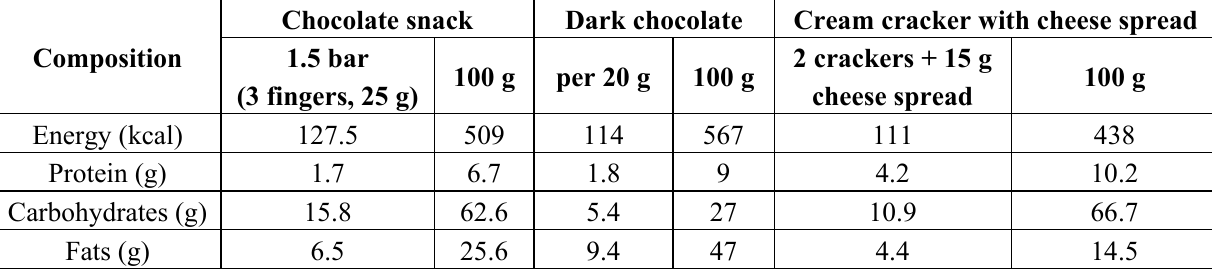
Table 3. Composition of the study